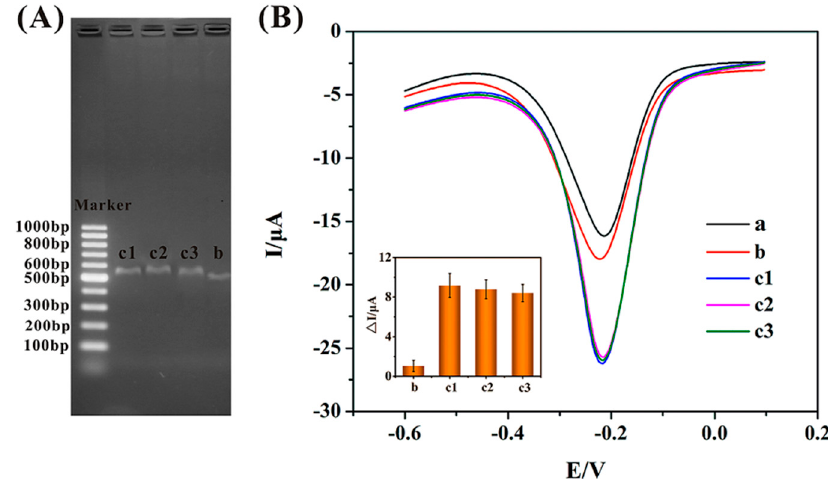
Figure 5. ( A ) Agarose gel electrophoresis diagram of asymmetric PCR products. From left to right: DL1002 marker, F. thunbergii (c1, c2 and c3), F. cirrhosa (b), respectively; ( B ) Differential pulse voltammograms of different PCR products exposed to Tris-HCl buffer blank control (a), and hybridized with F. cirrhosa (b), F. thunbergii (c1, c2 and c3). Inset: Histogram of pure peak current corresponding to F. cirrhosa (a) and different F. thunbergii (c1, c2 and c3).